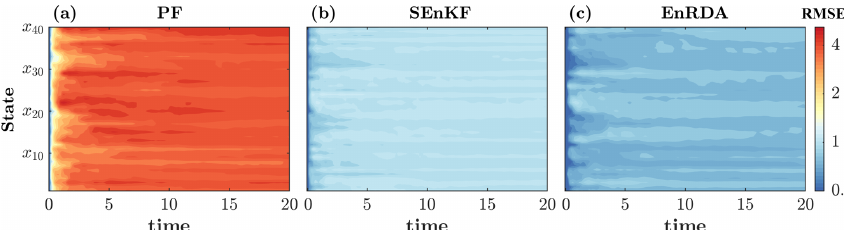
Figure 3. Temporal evolution of the root mean squared error (RMSE) for the (a) particle filter (PF) with 5000 particles, (b) stochastic ensemble Kalman filter (SEnKF), and (c) EnRDA, each with 50 ensemble members in a 40-dimensional Lorenz-96 system. The results report the mean values of 50 independent